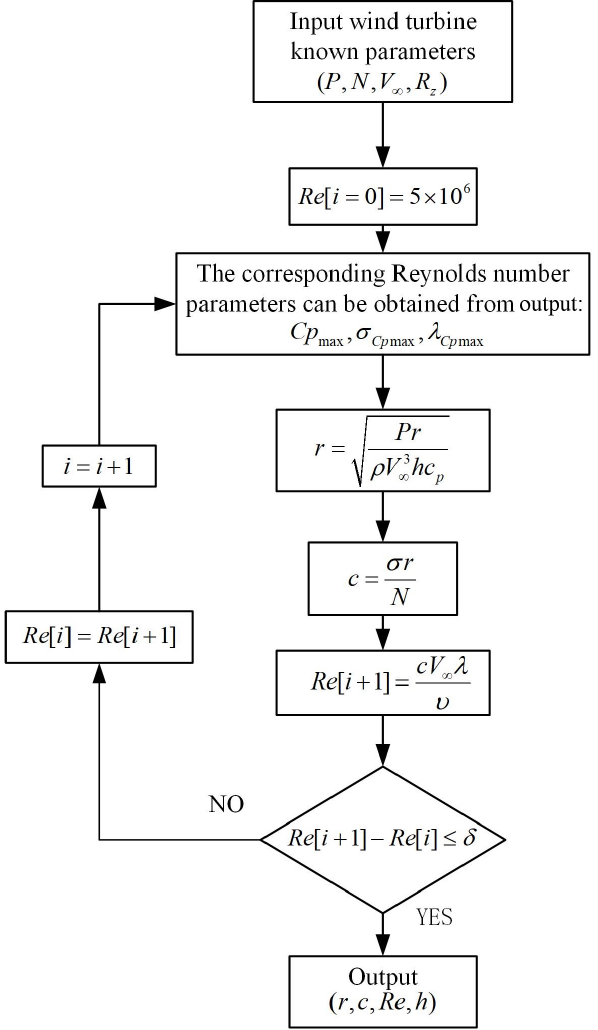
Figure 3. Iterative design process of offshore wind turbine.